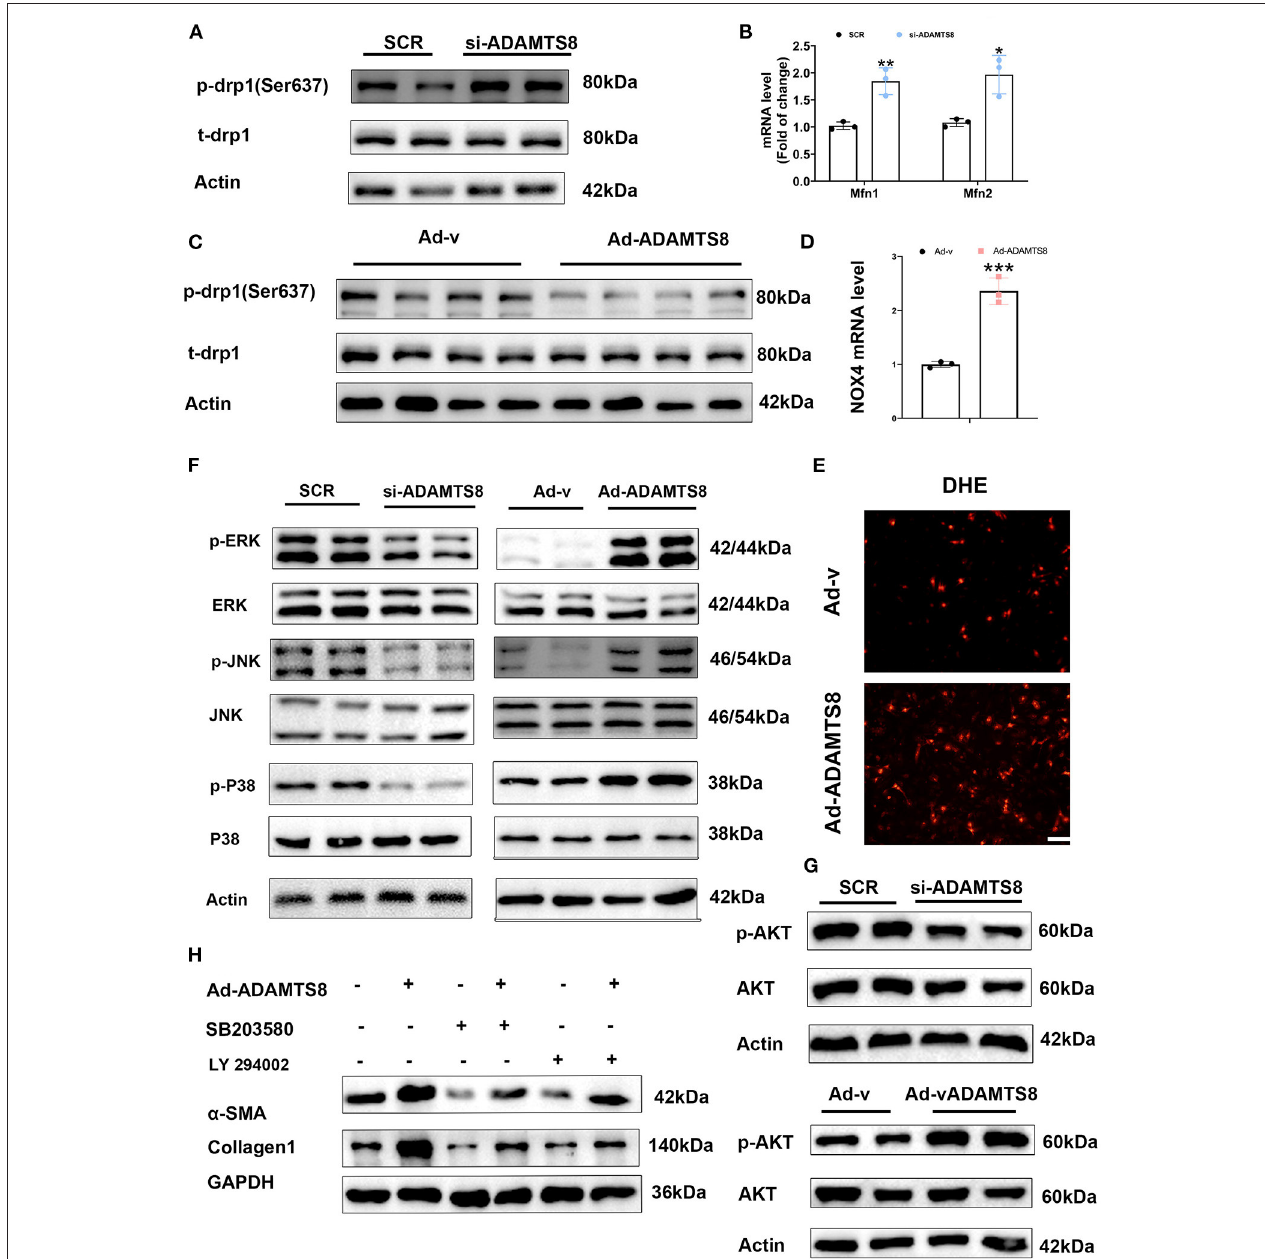
FIGURE 6 | ADAMTS8-mediated mitochondrial dysfunction in cardiac fibroblasts and activated ROS-sensitive pathways to regulate the fibrotic response. (A,C) Representative Western blot of DRP-1 (p-drp1) phosphorylated at Ser637 and total drp1 (t-drp1) in cultured cardiac fibroblasts infected with si-ADAMTS8 or ADAMTS8-overexpressing adenovirus. (B) Real-time polymerase chain reaction (RT-PCR) analyses of Mfn1 and Mfn2 mRNA in cultured cardiac fibroblasts infected with si-ADAMTS8. Average expression values were normalized to GAPDH mRNA. (D) RT-PCR analyses of NOX4 mRNA in cultured cardiac fibroblasts infected with ADAMTS8-overexpressing adenovirus average expression values were normalized to GAPDH mRNA. (E) Representative images of dihydroethidium (DHE) staining of CFs infected with ADAMTS8-overexpressing adenovirus. (F,G) Activation of MAPK and AKT in cultured cardiac fibroblasts overexpressing ADAMTS8 or downregulating ADAMTS8 detected via western blotting. (H) Cultured cardiac fibroblasts infected with ADAMTS8 overexpressing adenovirus treated with the MAPK pathway inhibitor SB203580 or AKT inhibitor LY294002 (25 uM) after quiescence, followed by analysis of the cell lysates with indicated antibodies. Data were presented as mean ± SEM. * P < 0.05, ** P < 0.01, and *** P < 0.001 between the two indicated